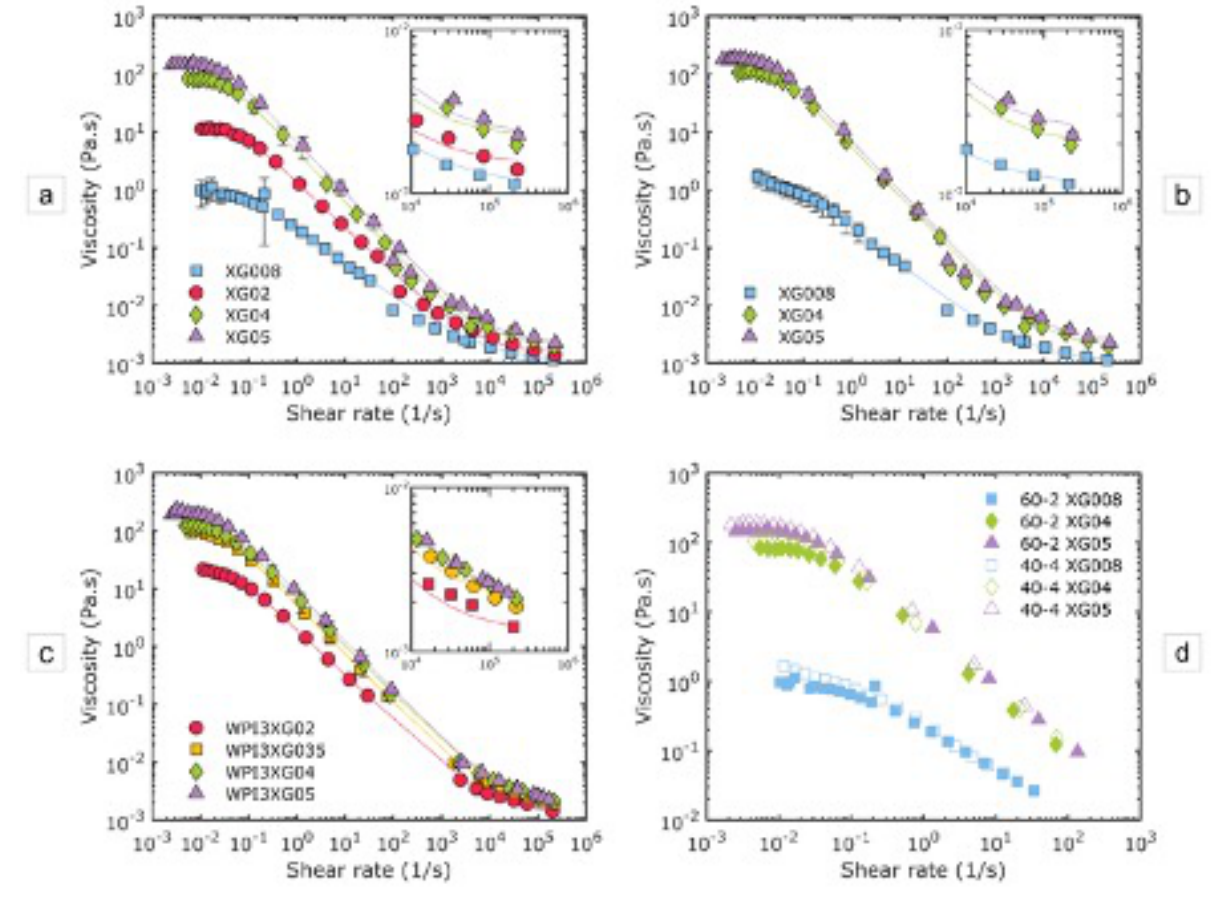
Figure 4: Flow curves and model fits. a) 60-2 cone-plate geometry + microfluidic rheometer for XG solutions. b) 40-4 cone-plate geometry + microfluidic rheometer for XG solutions. c) 40-4 cone-plate geometry + microfluidic rheometer for WPIXG solutions. d) comparison of viscosity data from rotational rheometer using cone-plate geometries 60-2 and 40-4 for XG